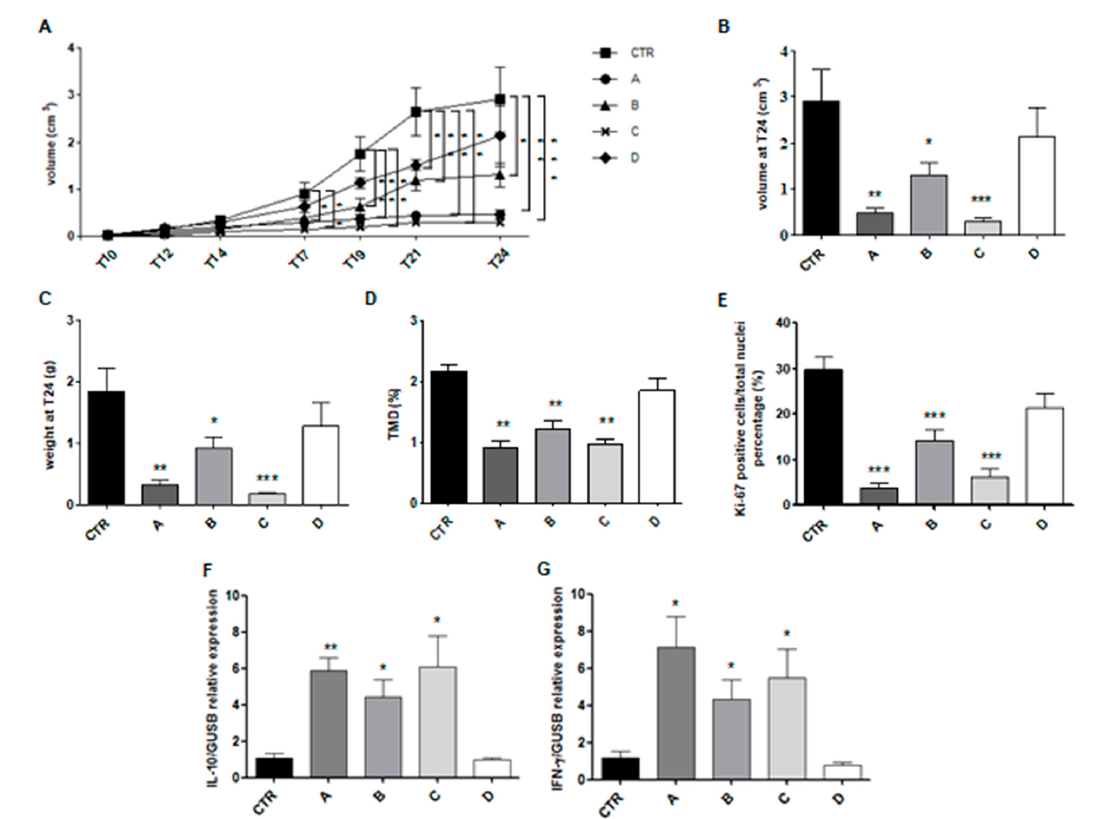
Figure 6. Results of animal experiments. Statistical analysis: ( A ) Tumour volume: formulations vs. CTR * p < 0.05; ** p < 0.01; *** p < 0.005; ( B ) Tumour volume at